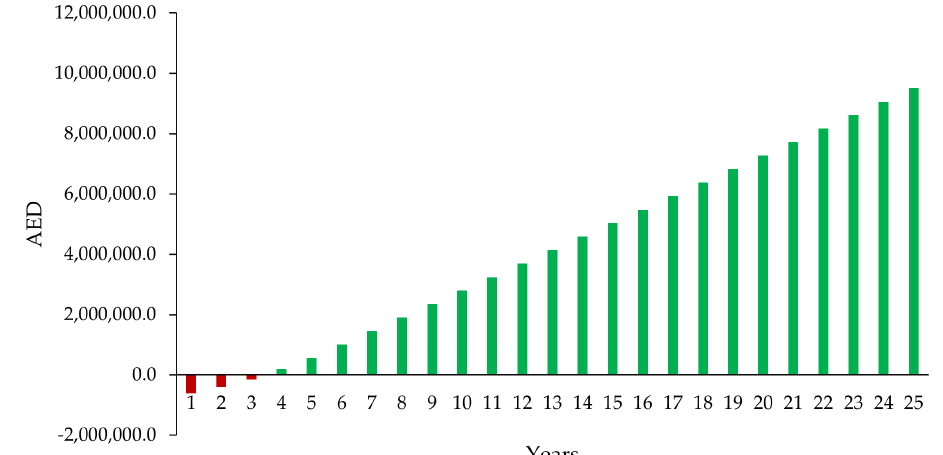
Figure 12. Payback period for the PV project.